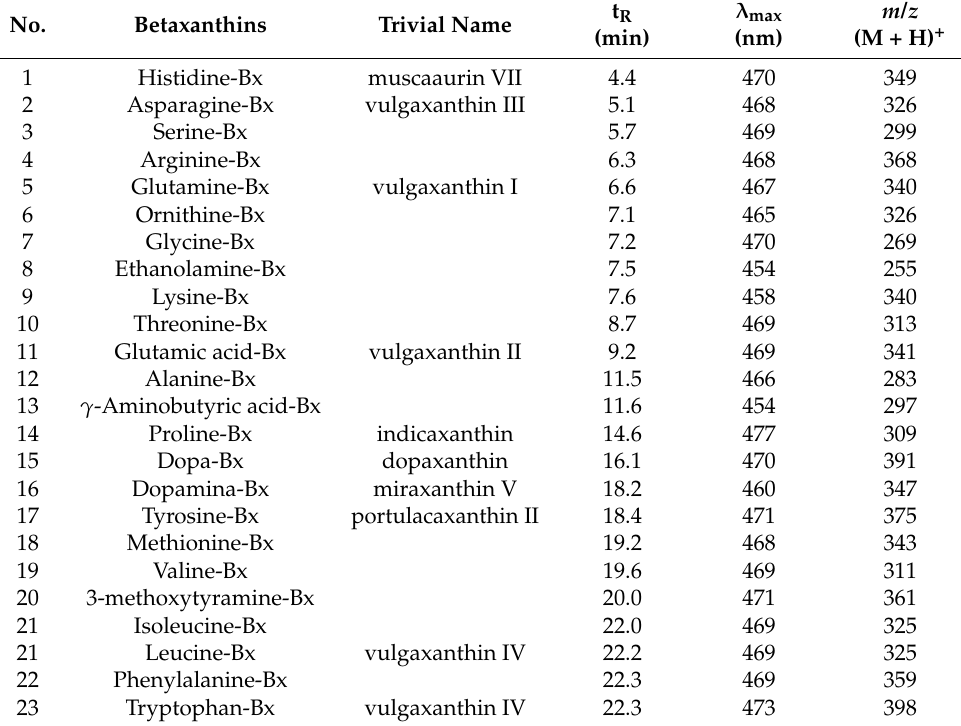
Table 1. Chromatographic, spectrophotometric, and mass-spectrometric data of analyzed betaxan- thins in fresh Beta vulgaris L. var. Ceryl, Chrobry, Forono, Tytus,